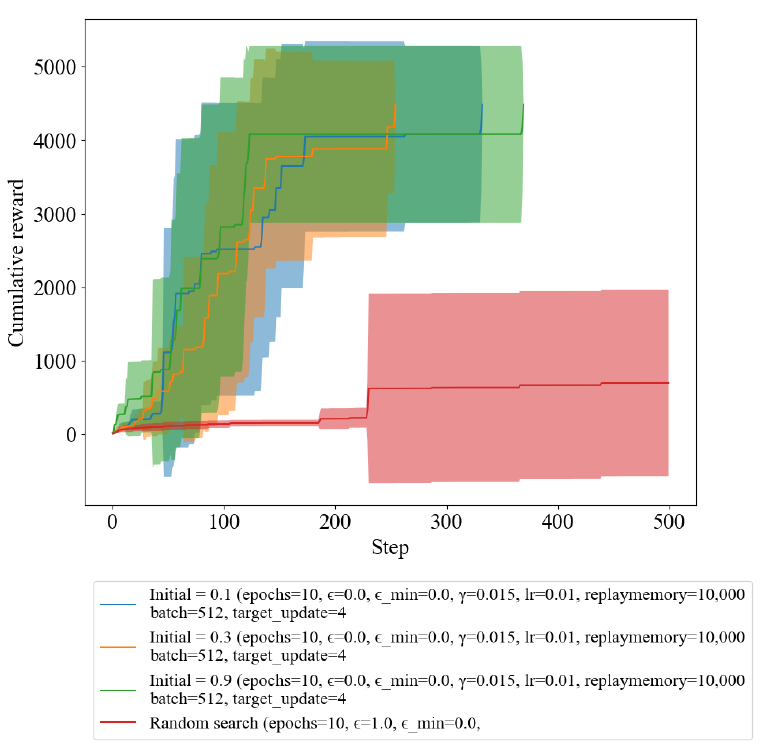
Figure 4. Reward of random search and DQL with varying epsilon values.